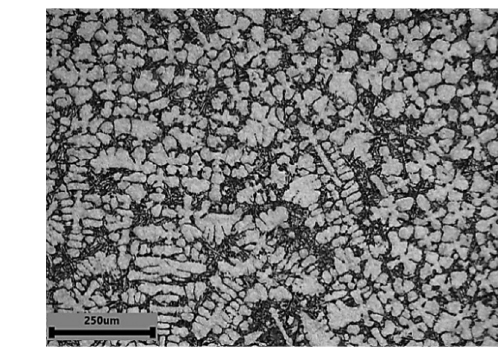
Figure 5. Light microstructures showing dendritic arrangements and their dependencies with cooling rates and growth velocities for the Al-10 wt.% Si-0.45 wt.% Mg alloy.